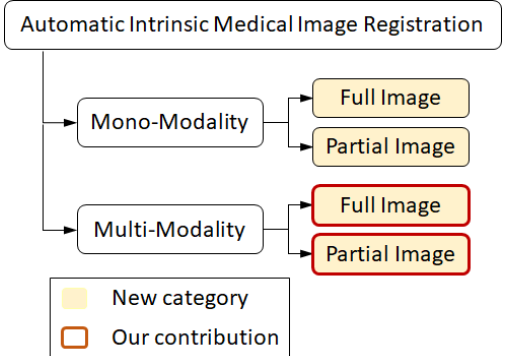
Figure 1. The proposed complementary taxonomy of medical image registration methods by considering the imaging modalities and image overlap. We also present a multi-modal image transformation pipeline that assists multi-modal image registration with full or partial overlap by its current